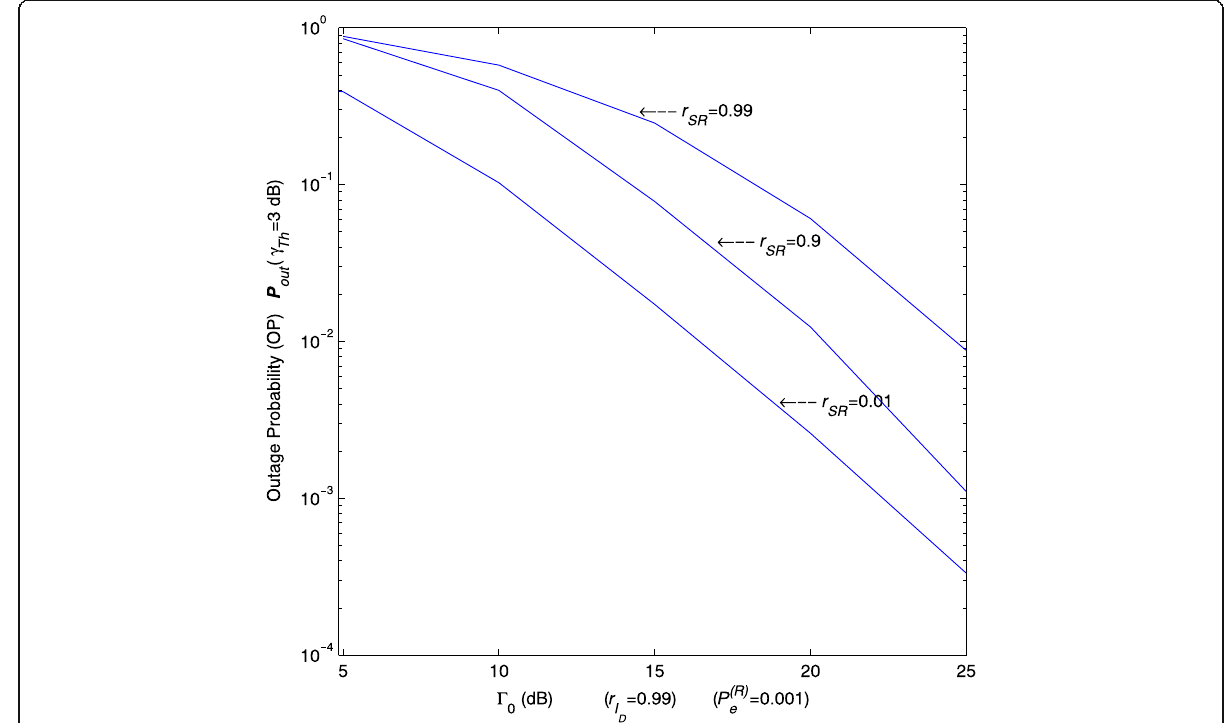
¼ 0 : 99), and thermal noise, D